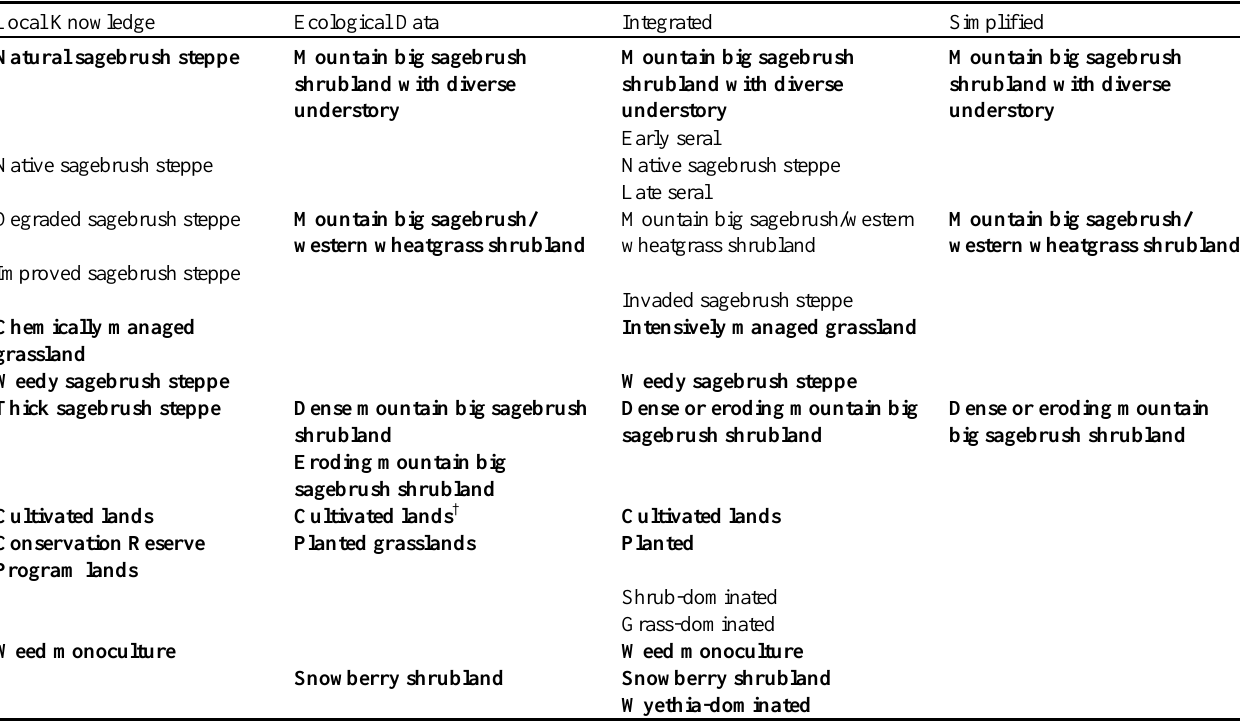
Table 2 . States (bold) and communities (plain text) of the Mountain Loam ecological site, northwest Colorado, USA, drawn from an iterative model building process (see Fig. 1). Similar states and communities from different modeling steps are on the same line. Many states and communities were identified at multiple modeling steps, and the Simplified model reflects states about which there was the most